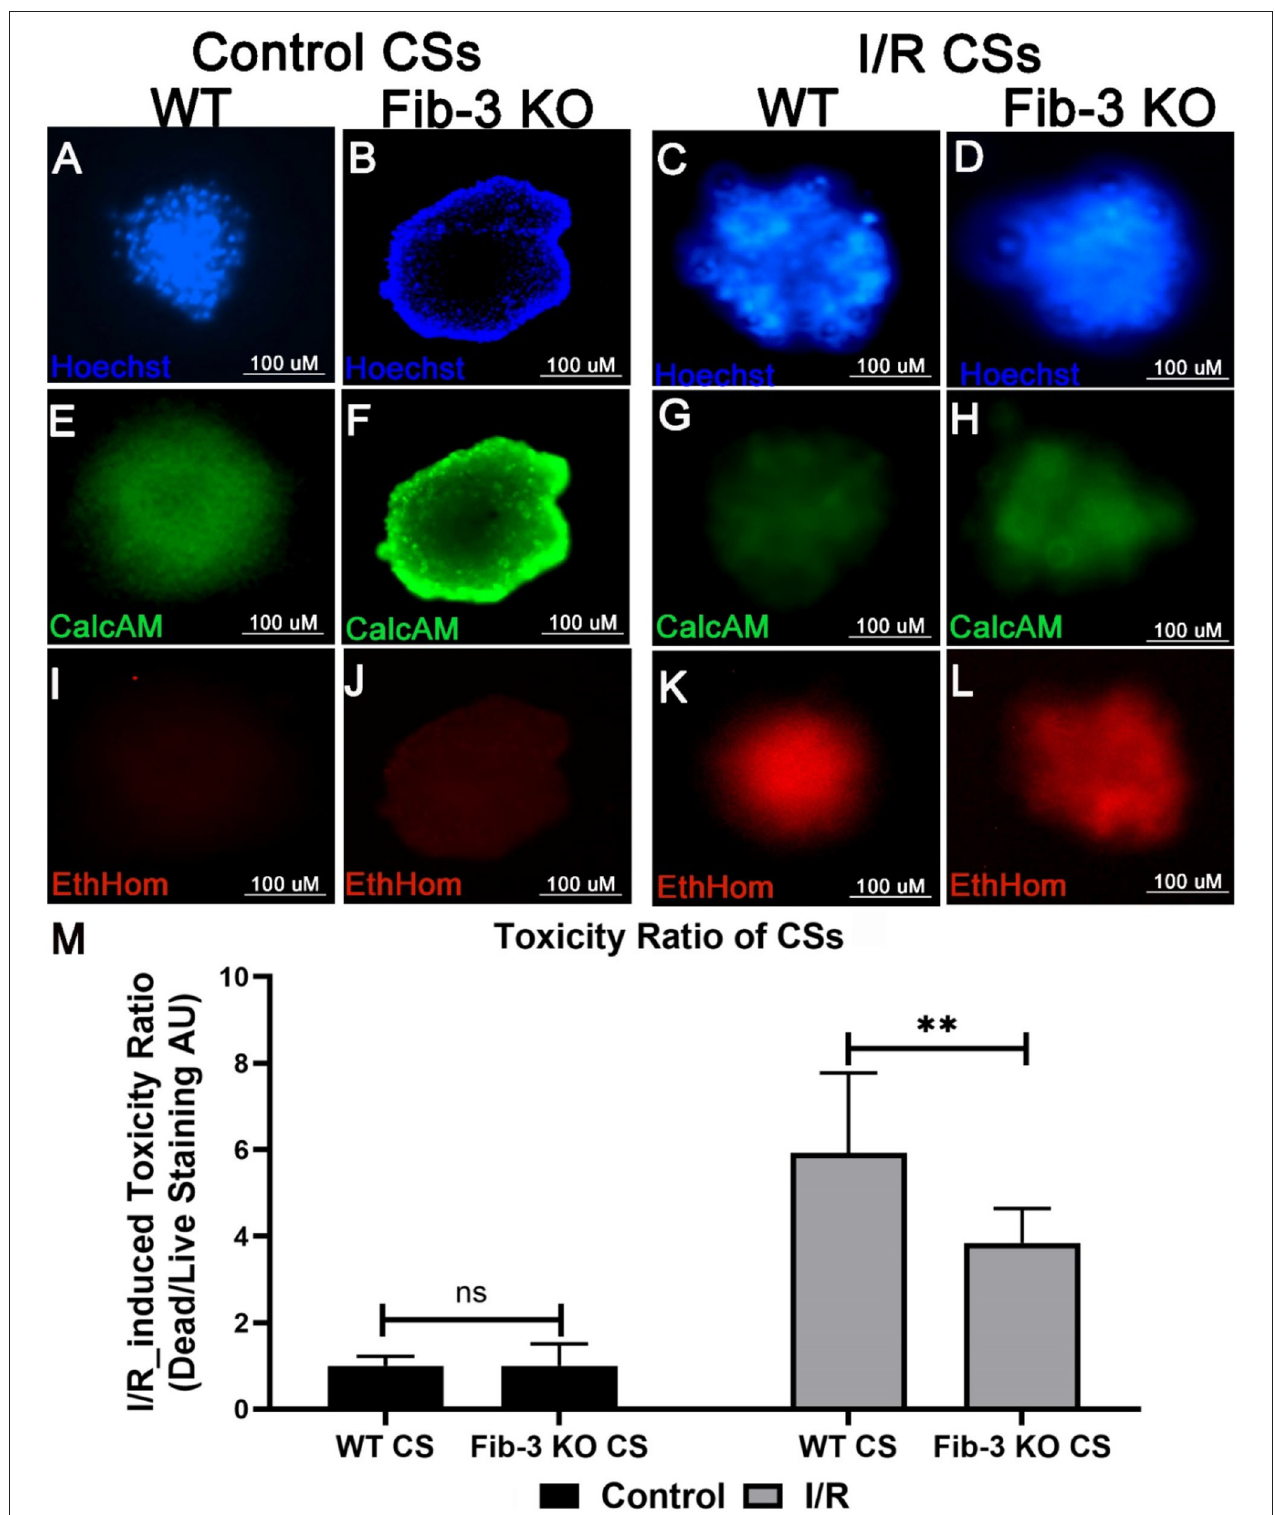
FIGURE 4 | Fib-3 KO CSs are less sensitive to changes in oxygen concentrations compared with WT CSs. (A–L) Representative images of control and I/R WT and Fib-3 KO CSs stained with calcein-AM (green), ethidium homodimer (red) and Hoechst stain (blue), staining live, dead, and total cells, respectively. (A–D) stained with Hoechst, (E–H) with calcein-AM, and (I–L) and ethidium homodimer. (M) Statistical analyses of toxicity ratios for control and I/R CSs. Two-way ANOVA with Sidak’s multiple comparison test, p > 0.05 = ns and p < 0.01 = **. Error bars represent the mean ± SD ( n > 6).